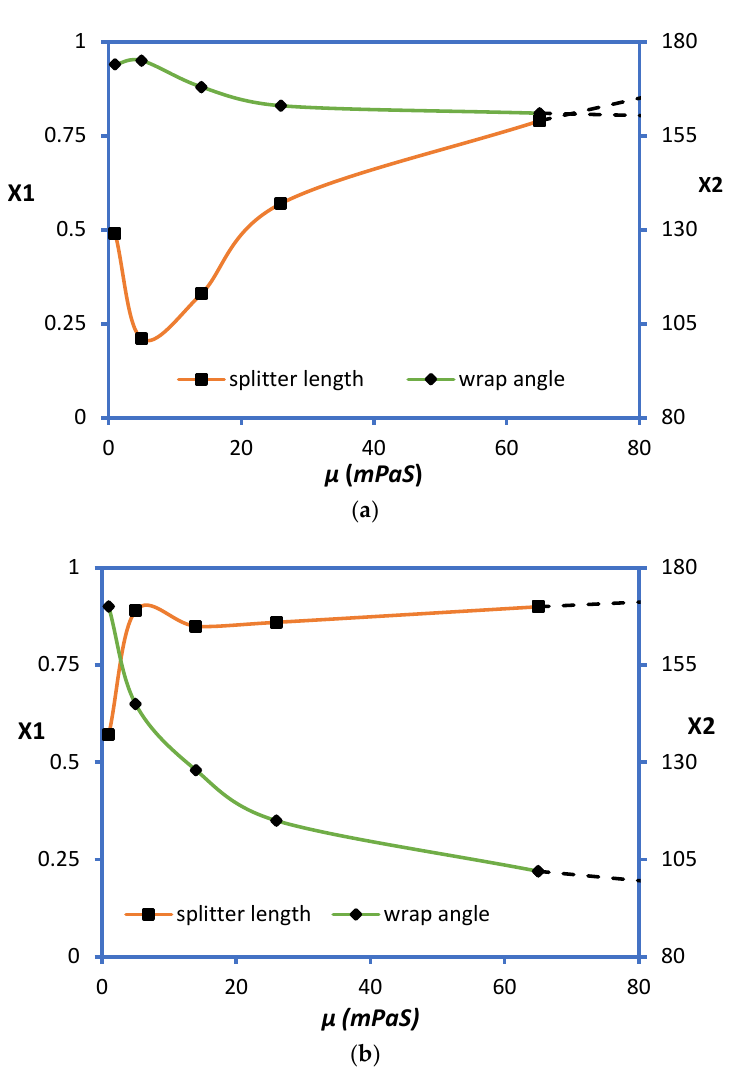
Figure 24. Relationship X1 and X2 with µ for ( a ) minimizing input power ( Ψ ), ( b ) maximizing head ( H ).